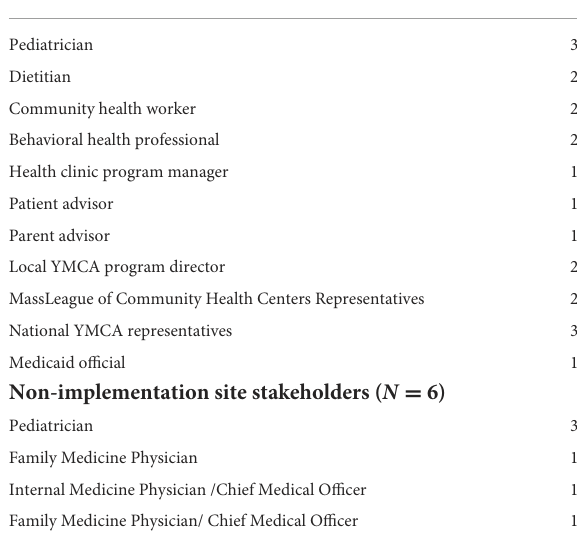
TABLE 1 Participants in the Stakeholder Clinic and Community Approaches to Healthy Weight study (MA-CORD 2.0) qualitative